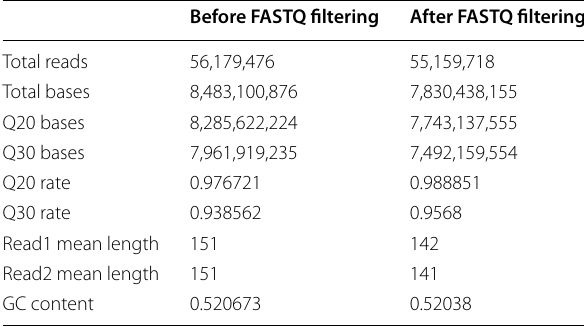
Table 2 The statistical parameters of FASTQ files of the patient before and after performing filtering steps in whole-exome sequencing (WES) pipeline